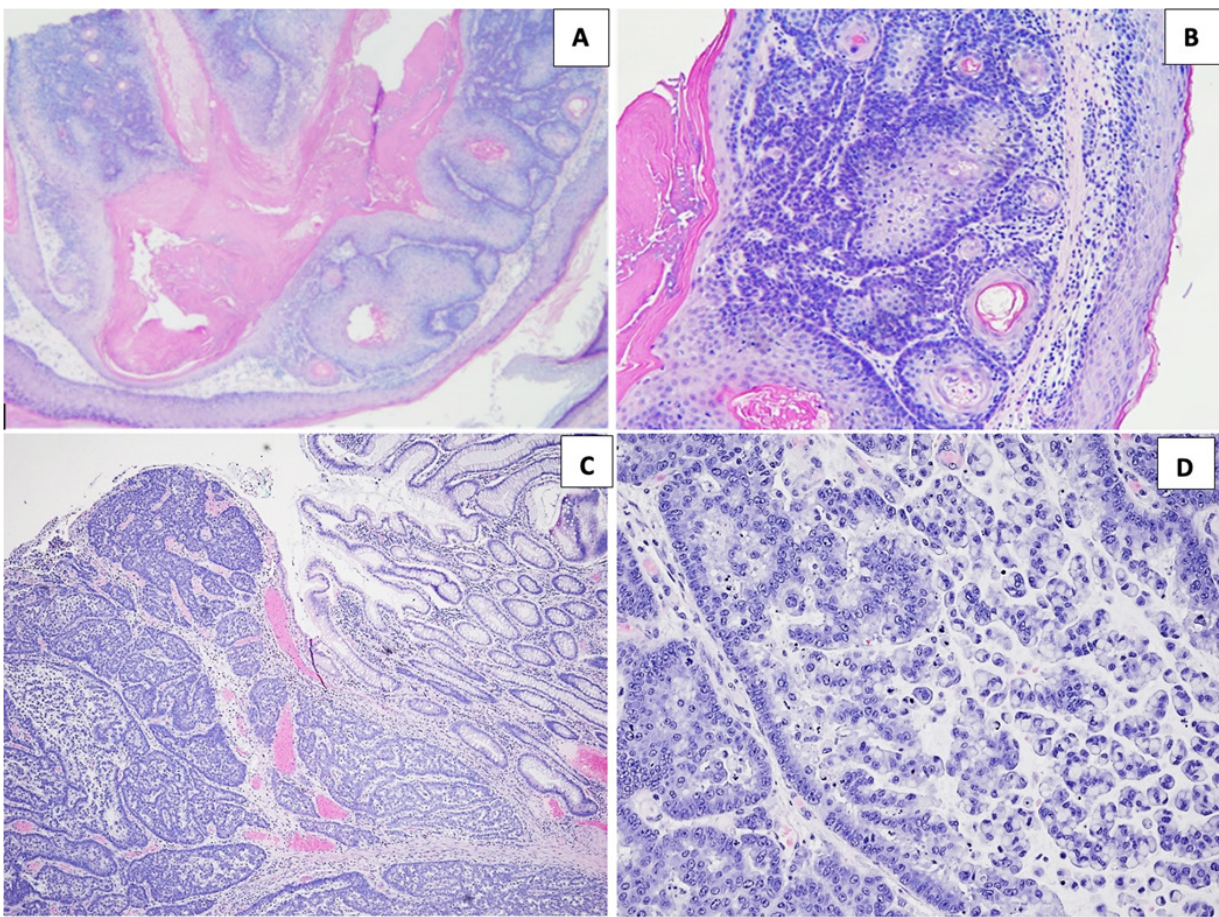
Figure 2: ( A) Sebaceous adenoma in the dermis with cystic dilatation (Hematoxylin and Eosin ×40). (B) Proliferation of ger- minative cells in the sebaceous adenoma (Hematoxylin and Eosin ×200). (C) Low magnification view of the colonic adenocar- cinoma with normal colon on the right and the adenocarcinoma with mostly solid architecture (Hematoxylin and Eosin ×40). (D) Poorly differentiated adenocarcinoma of colon with pleomorphic tumor cells and poorly formed glands with some extracel- lular and intracellular mucin (Hematoxylin and Eosin